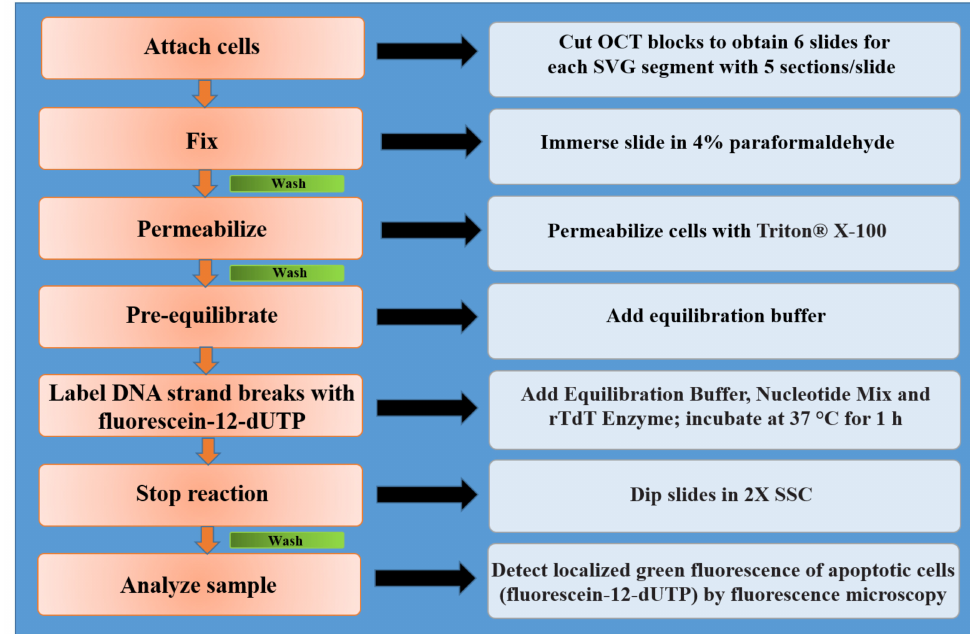
Figure 2. Protocol overview for use of the DeadEnd™ Fluorometric TUNEL System in fluorescence microscopy of the attached